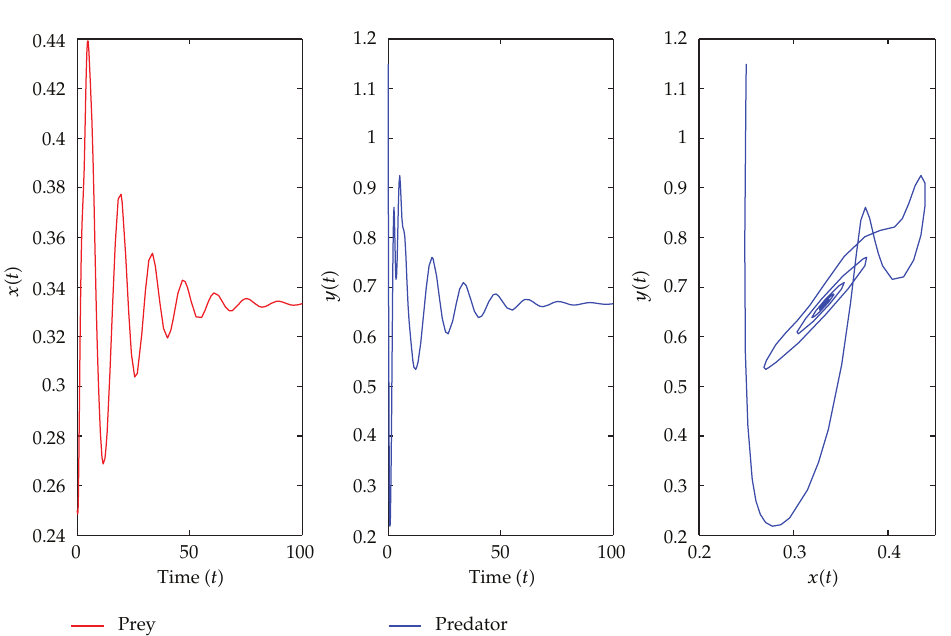
Figure 7: E (cid:7) 0 . 3333 , 0 . 6666 (cid:8) is asymptotically stable when τ 1 (cid:6) 3 . 25 < τ 1 ∗ (cid:6) 3 . 7457 with τ 2 (cid:6) 0 . 5 and initial value 0.25, 1.15.